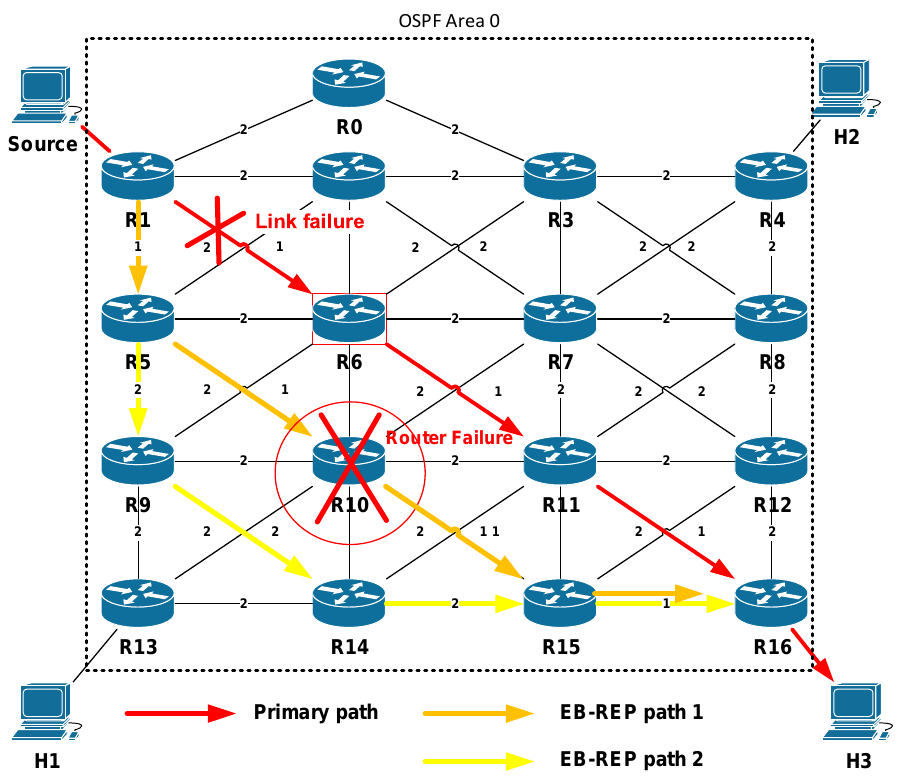
Figure 12. EB-REP simulation topology.